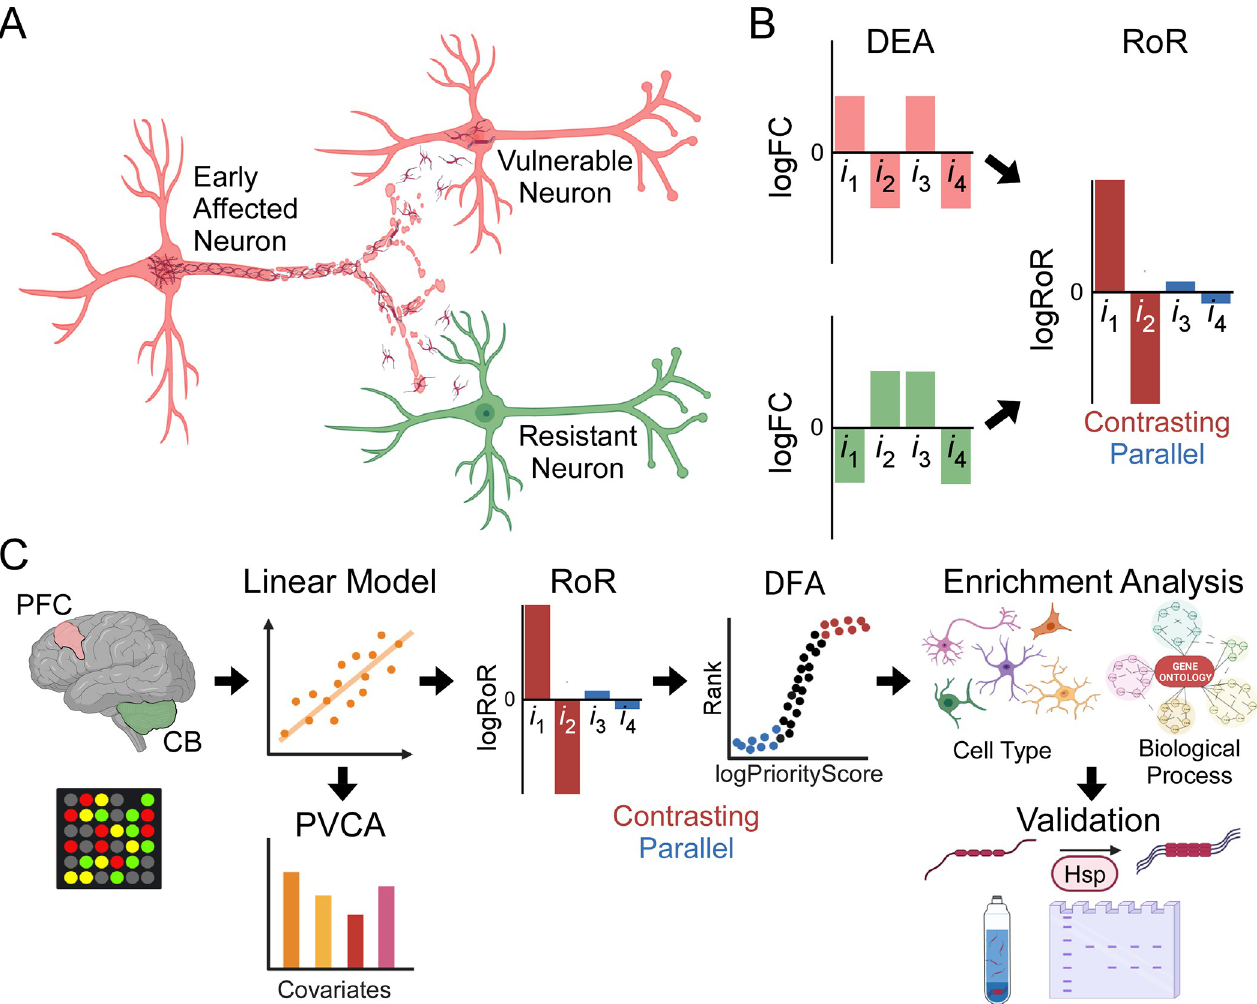
Fig 1. Approach for identifying gene expression changes associated with resistance to tauopathy. ( A ) Early affected neuron undergoing tauopathic neurodegeneration projects tau seeds to downstream neurons, some of which are vulnerable to prion-like templating and degeneration whereas others are resistant. ( B ) The ratio of ratios (RoR) approach extends differential expression analysis (DEA) by disaggregating region-specific log fold changes (logFC; disease versus normal control) into parallel and contrasting components, reflecting common and differing responses to tauopathy, respectively (illustrated for hypothetical gene transcripts i 1-4 ). ( C ) Analysis pipeline from microarray measurement of gene expression to biological validation. See text and S1 Code for details. Created with